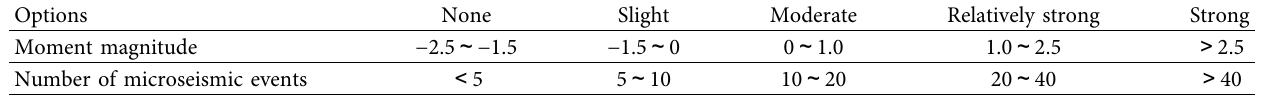
Table 1: Determination method of the rockburst grade.